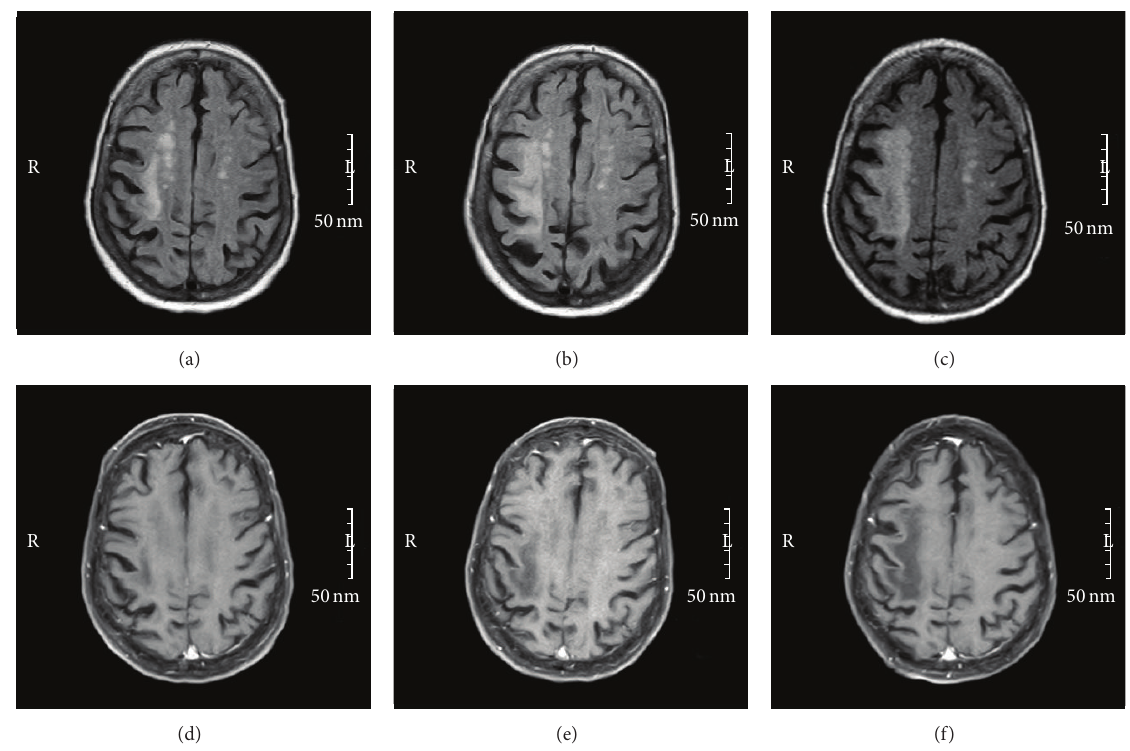
Figure 1: Top row: MRI head, axial T2-FLAIR. Bottom row: MRI head, T1-post gadolinium contrast in same chronological order (right to left). Note the prominent progressive asymmetric subcortical T2-FLAIR signal abnormality over the course of 12 weeks with noted lack of pathological enhancement during the same time window. (Left) image: week 1, middle: week 6, and right: week 12. Lumbar puncture was obtained after the second MRI